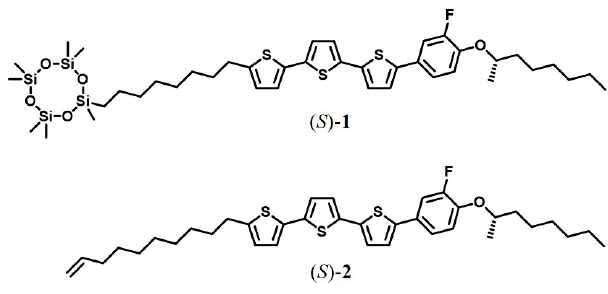
Figure 1. Chemical structures of LC fluorophenylterthiophene derivatives ( S ) − 1 and ( S ) − 2 . Table 1. Phase transition behaviors LC fluorophenylterthiophene derivatives ( S ) − 1 and ( S ) − 2 . Compounds